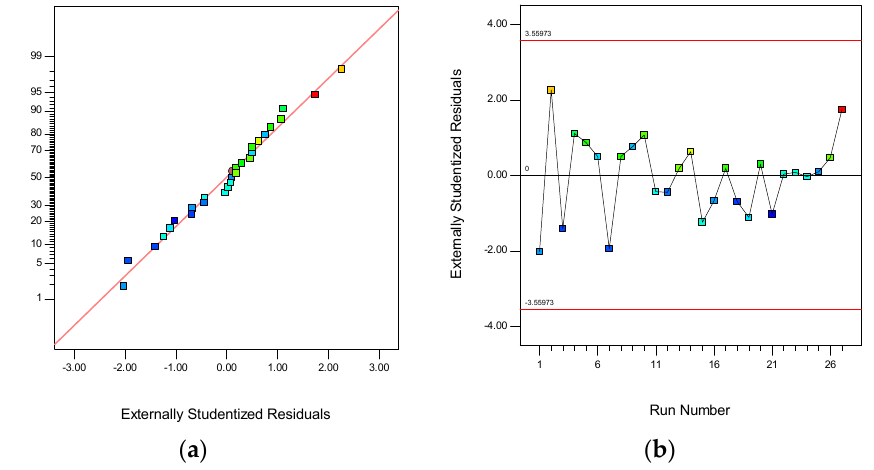
Figure 10. Diagnostic plots for impact strength response: ( a ) normal probability; ( b ) residuals vs run.